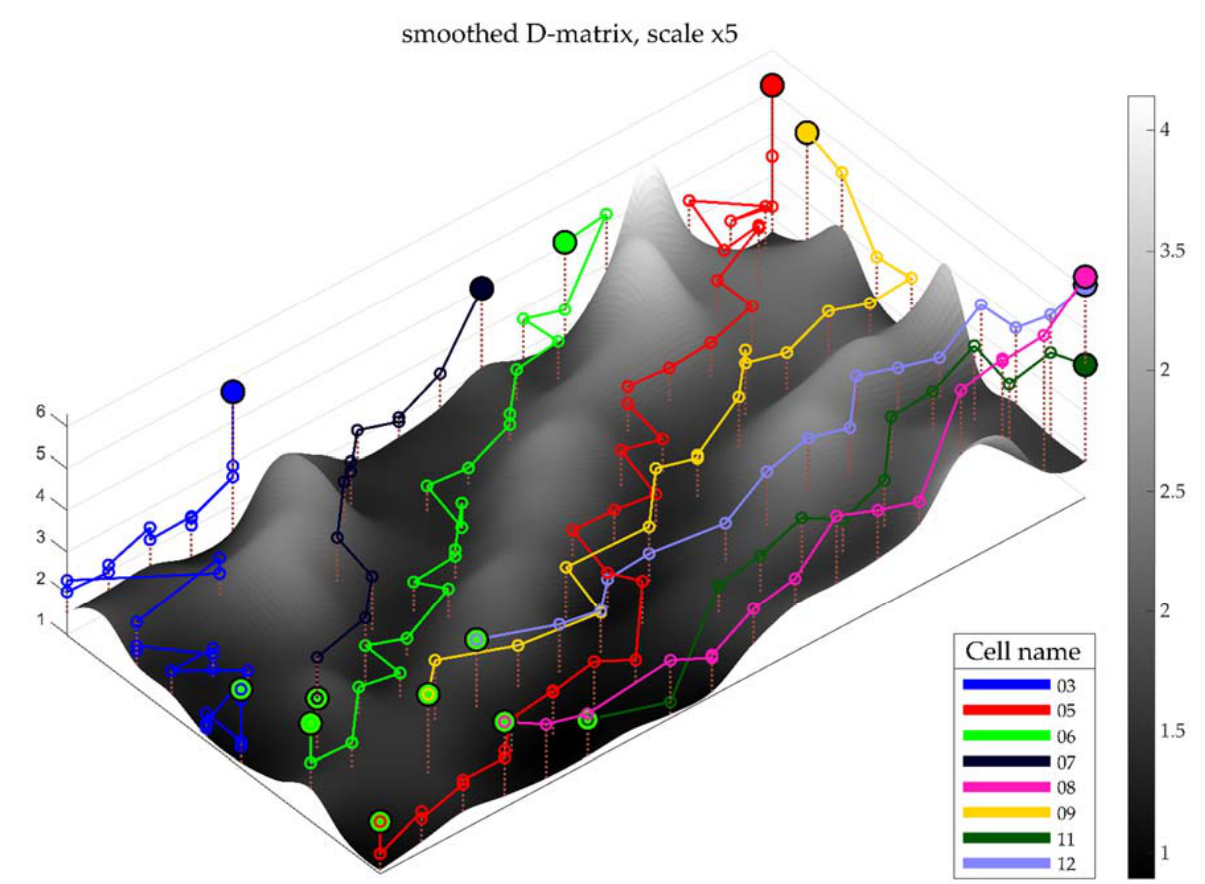
Figure 13. D visualization (geographic metaphor) of the D-matrix and trajectories for eight cells. The first BMU of each cell is marked with a green dot, the more aged one is marked with a dot of its own color.